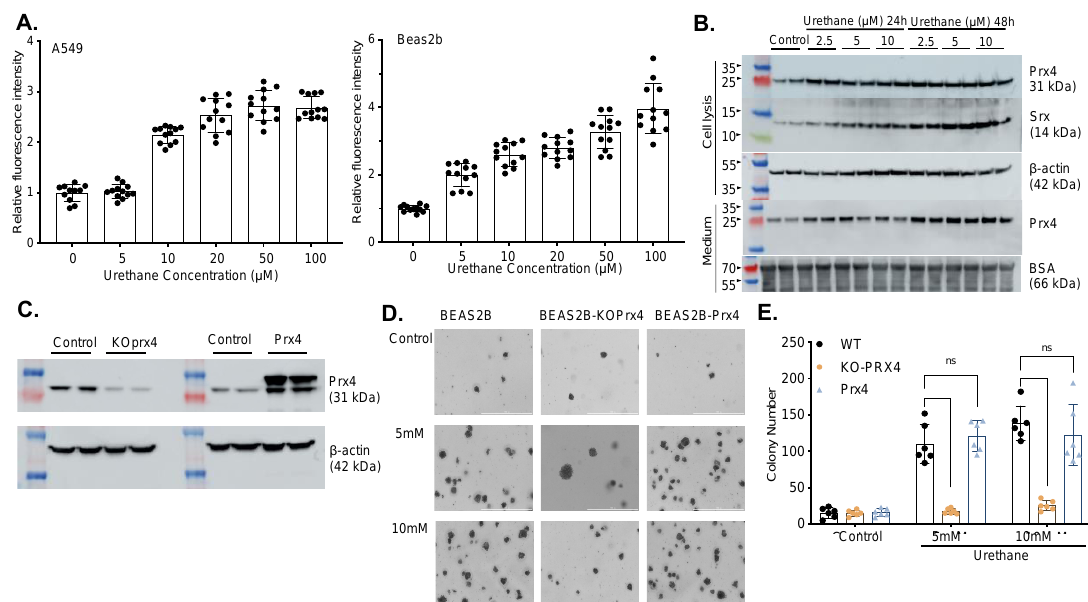
Figure 3. Urethane induces ROS level and cell transformation through increased Srx expression and Prx4 secretion in normal lung epithelial cells. ( A ) ROS levels change with urethane treatment in normal and cancer cell lines. ( B ) Change of intracellular Srx and Prx4 levels and secreted Prx4 with urethane treatment. ( C ) Confirmation of establishment of knockdown/overexpress Prx4 cell line ( D , E ) Change of cell transformation with urethane treatment. (ns, p ≥ 0.05).